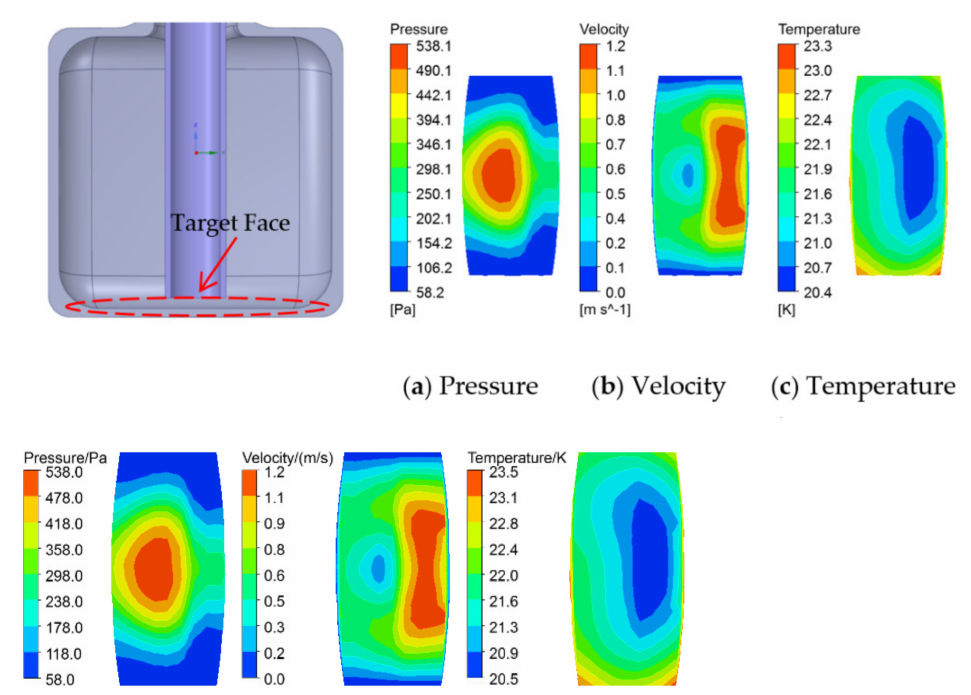
Figure 12. Physical parameters distribution of target surface: ( a ) Pressure; ( b ) Velocity; ( c )